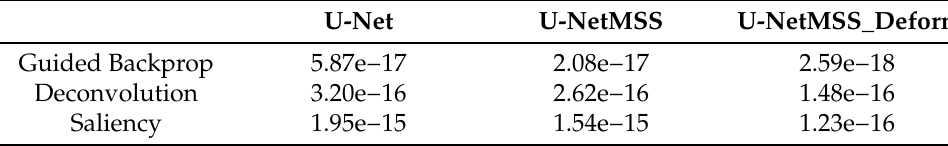
Table 1. Infidelity scores.